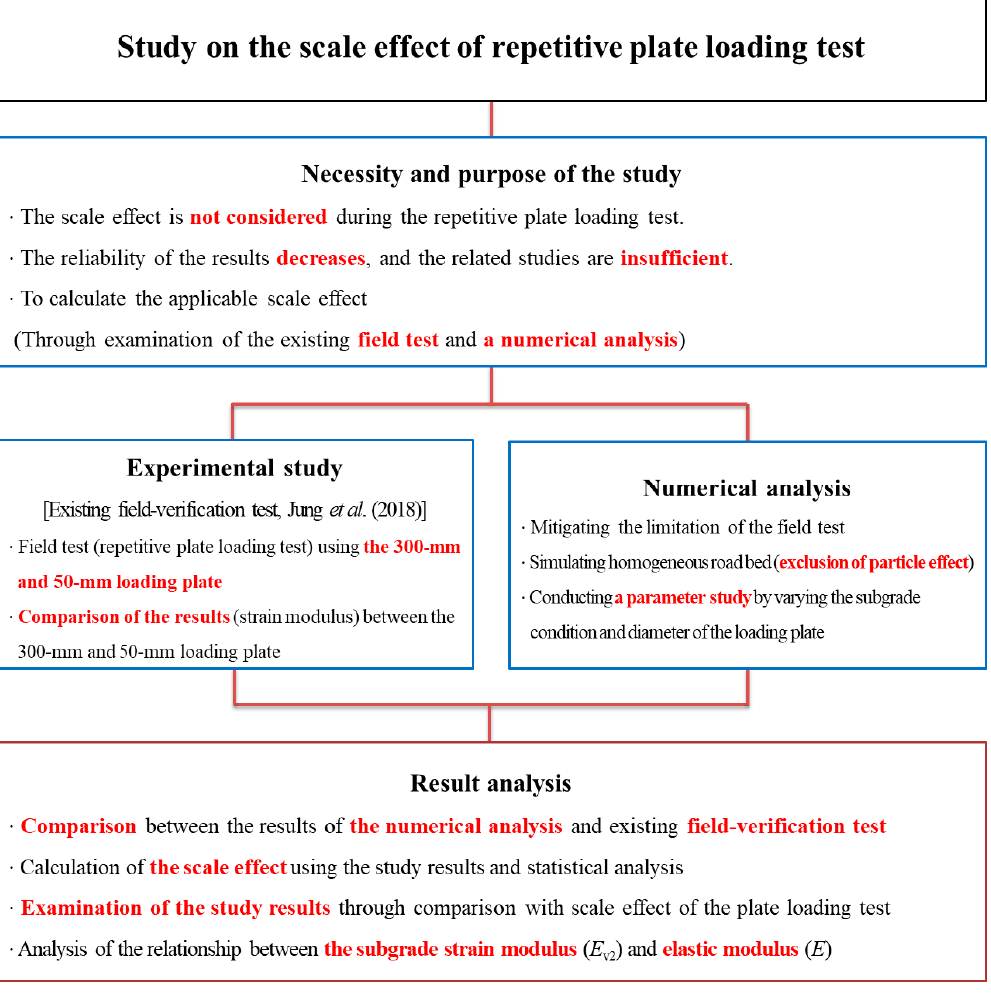
Figure 1. Study summary and flowchart.